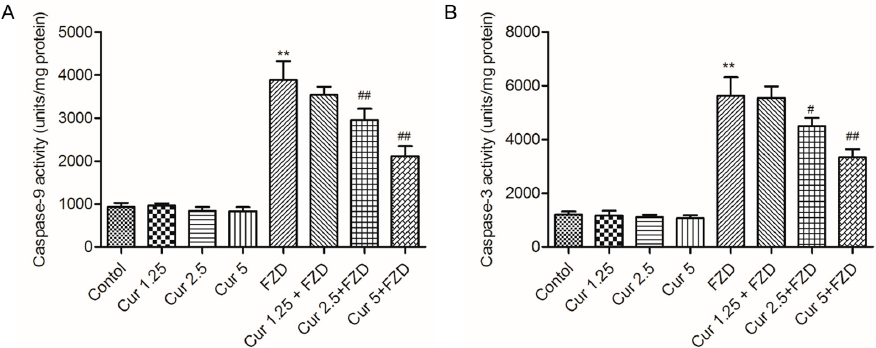
Figure 4. Curcumin treatment attenuated the increases of caspase-9 and -3 activities caused by FZD exposure . L02 cells were pretreated with curcumin at 1.25, 2.5 and 5 µM for 2 h, followed to wash with PBS twice, then exposed with or without FZD at 40 µg/mL for additional 24 h, caspase-9 ( A ) and -3 ( B ) activities were measured, respectively. Values were presented as mean ± SD, from three independent experiments. ** p < 0.01, compared to the negative control group; # p < 0.05, ## p < 0.01, compared to the FZD alone treatment group.